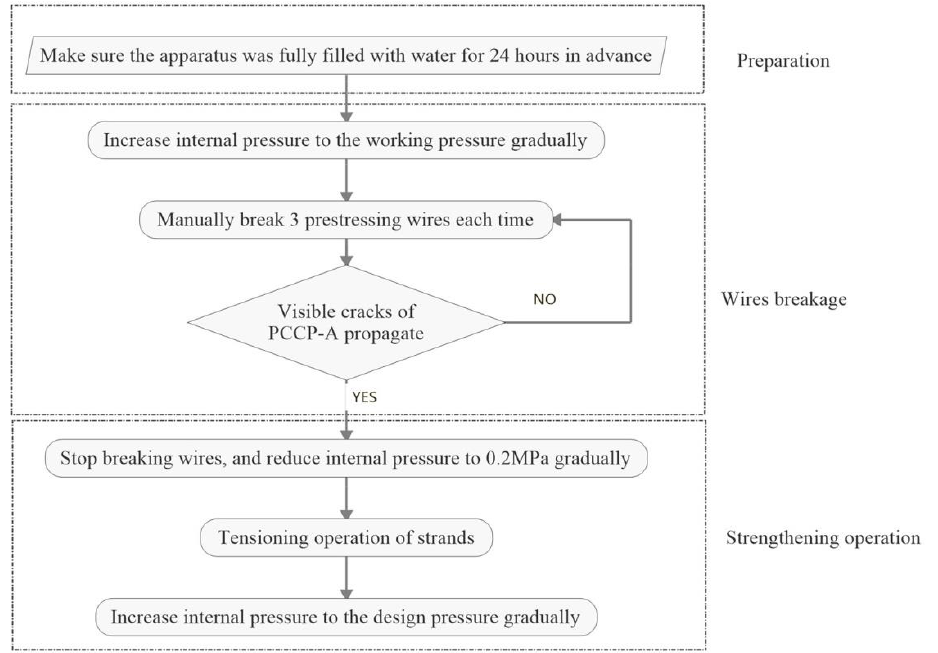
Figure 6. Load condition and load steps.